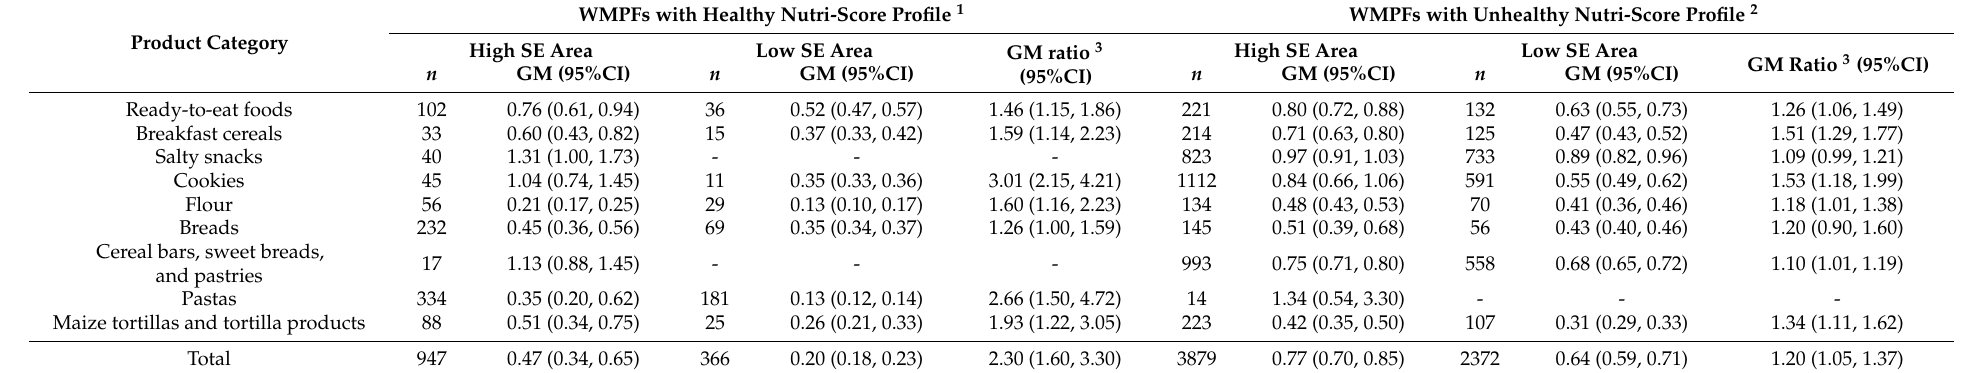
Product Category